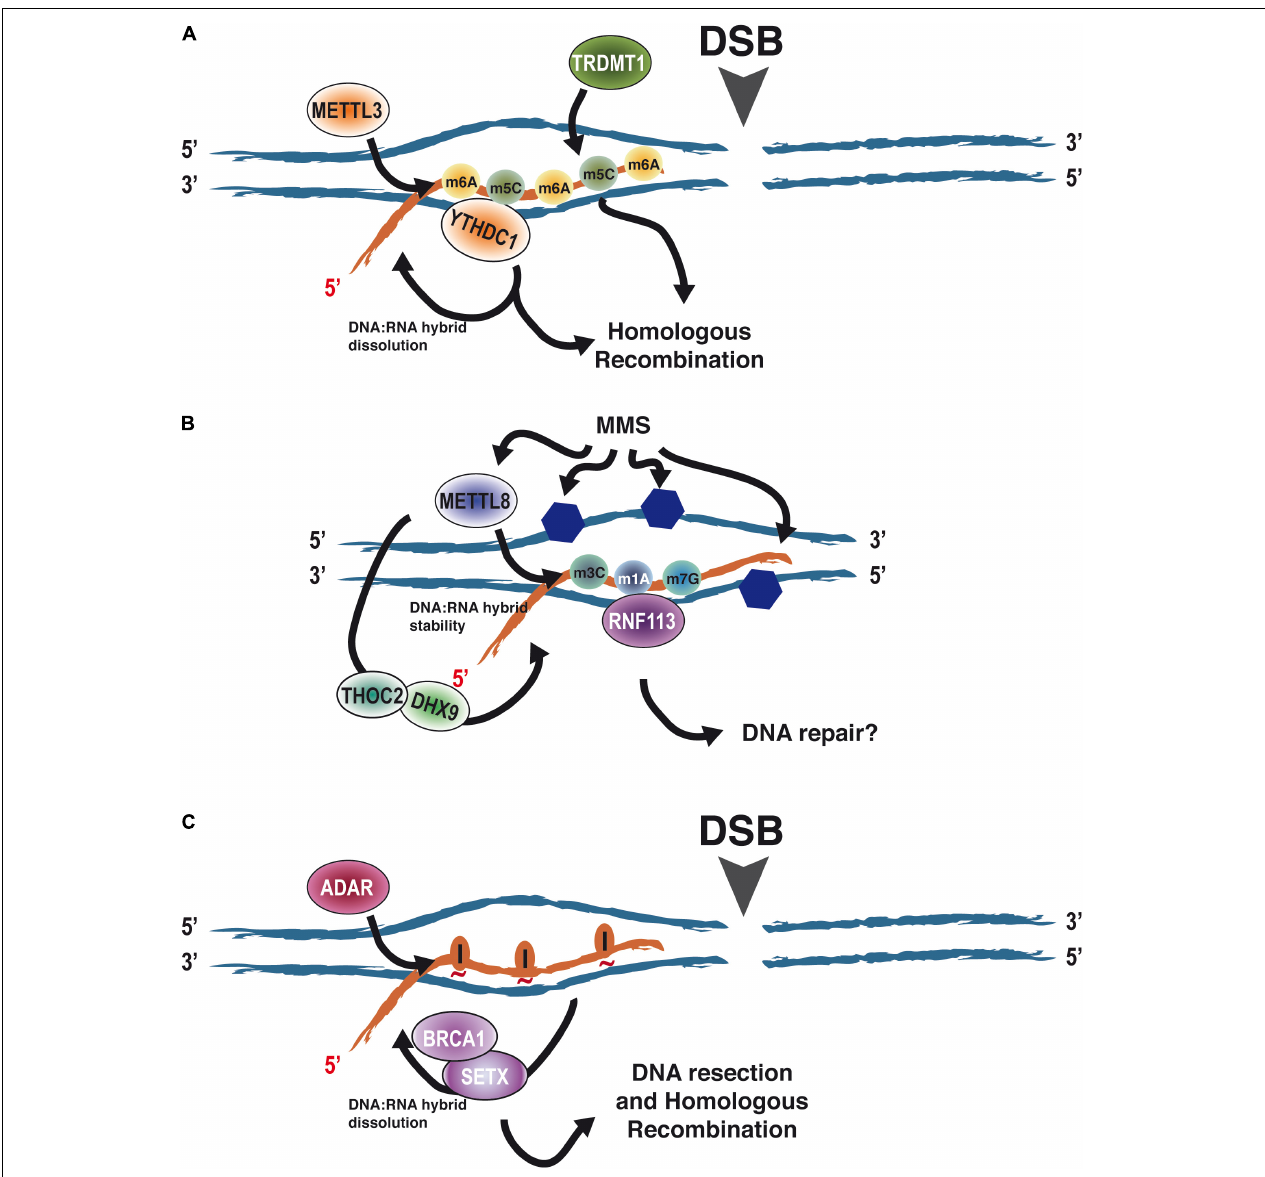
FIGURE 3 | The role of RNA modifications in the context of DNA:RNA hybrids on DNA repair. (A) RNA modifications such as m6A and m5C have been shown to accumulate upon the appearance of a DNA DSB on DNA:RNA hybrids due to the recruitment of the writers METTL3 and TRDMT1. Such modifications promote homologous recombination. At least in the case of m6A, this relies on the regulation of DNA:RNA hybrid stability through the eraser YTHDC1. (B) MMS causes the alkylation of DNA (blue hexagons) and the induction of the modifications m3C, m1A, and m7G on RNA by METTL8. On the other hand, METTL8 has been proposed to modulate DNA:RNA hybrid stability through THOC2 and DHX9, thus opening the possibility of such modifications happening in the context of R-loops. Furthermore, RNF113 has been shown to interact with m3C, m1A, and m7G after MMS treatment, stimulating DNA repair. Whether, in addition to its role in the spliceosome, this happens in the context of R-loops is an open question. (C) The appearance of a DSB stimulates the transient recruitment of ADAR proteins. Its A-to-I editing activity is required to facilitate DNA:RNA hybrid removal by SETX and BRCA1 prior to DNA end resection. We propose that this is mediated by loosening the interaction between the RNA and DNA moieties as inosines will not pair with the opposing thymines (red tilde). Abbreviations: adenosine deaminases acting on RNA.